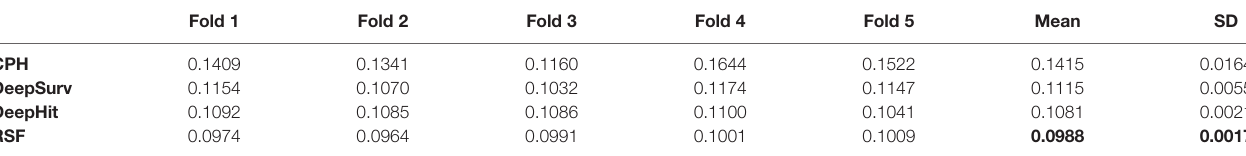
TABLE 3 | IBS for Cross-validation.